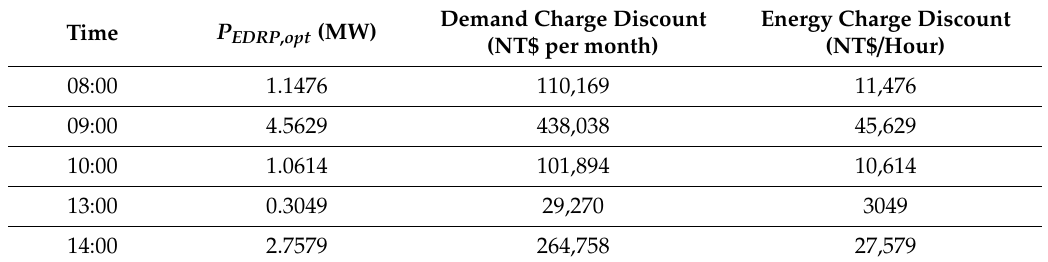
Table 8. The cost analysis and required capacity of the EDRP